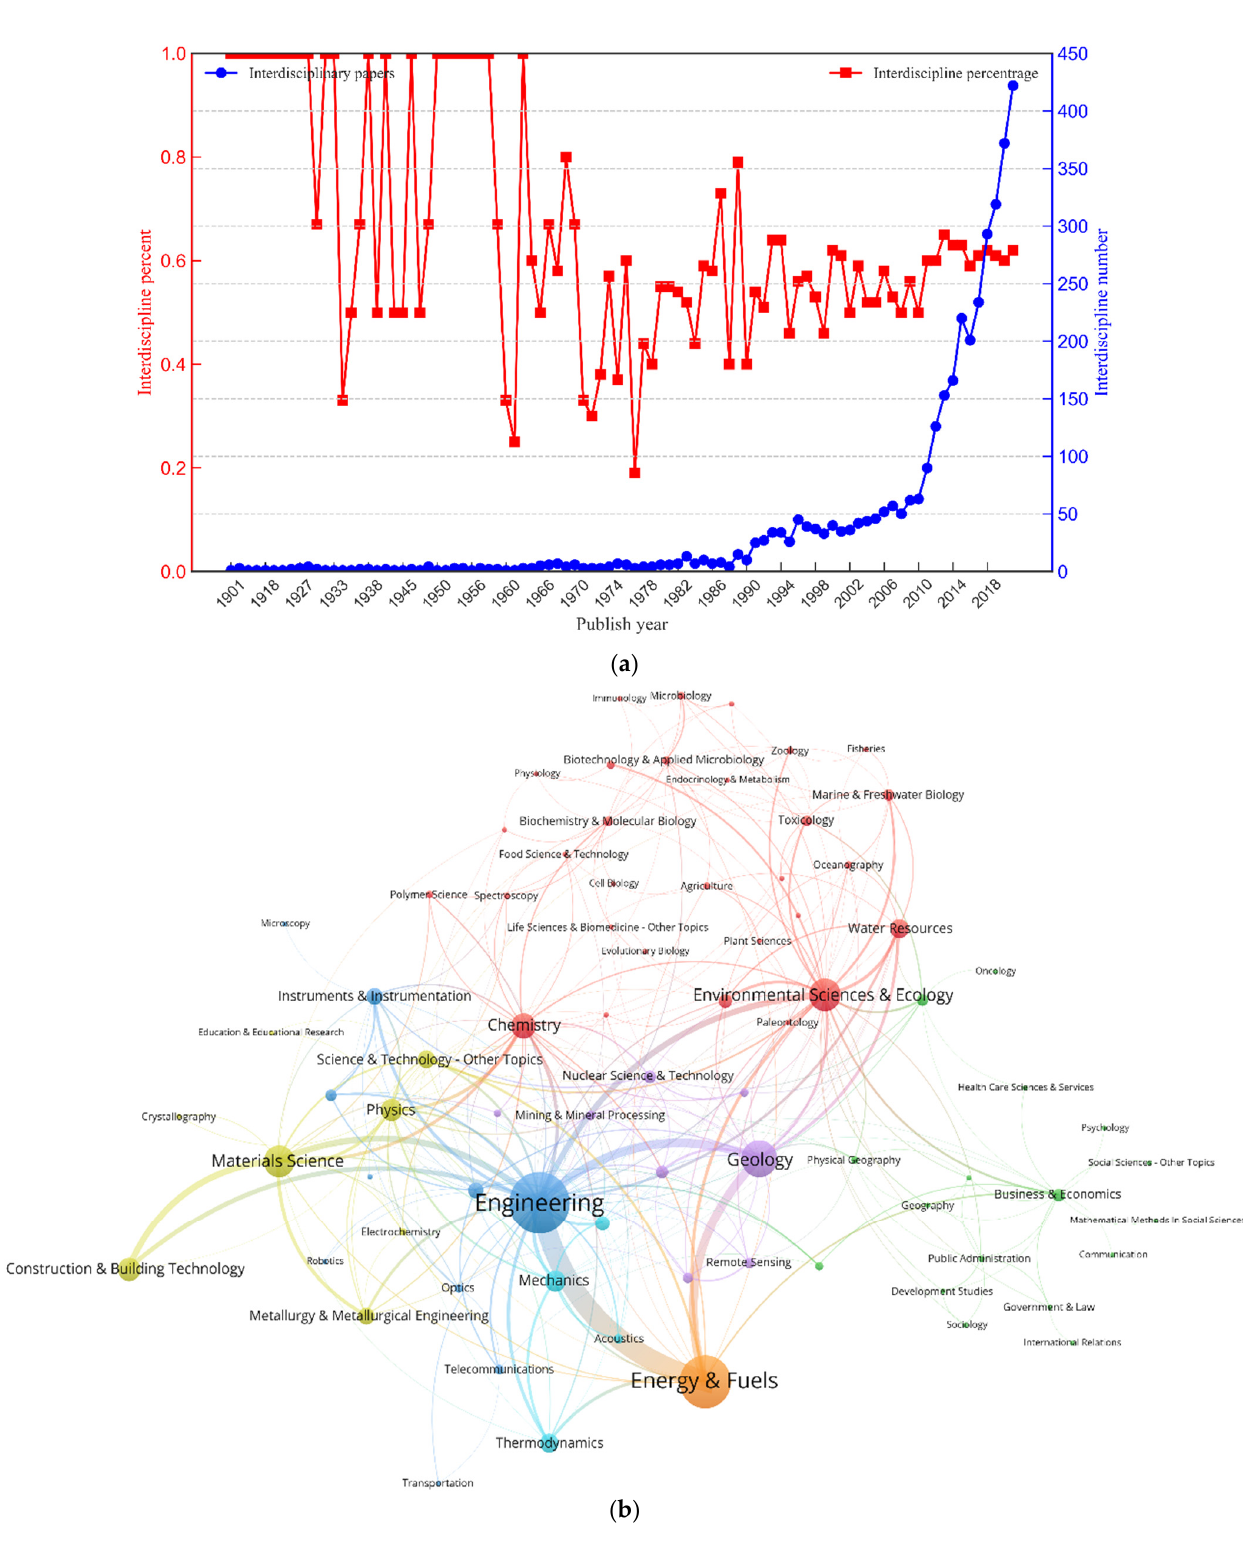
Figure 4. ( a ) Annual number variation of interdisciplinary papers and corresponding proportion between 1900 and 2021. ( b ) Disciplinary co-occurrence network in the field of oil and gas well re- search.